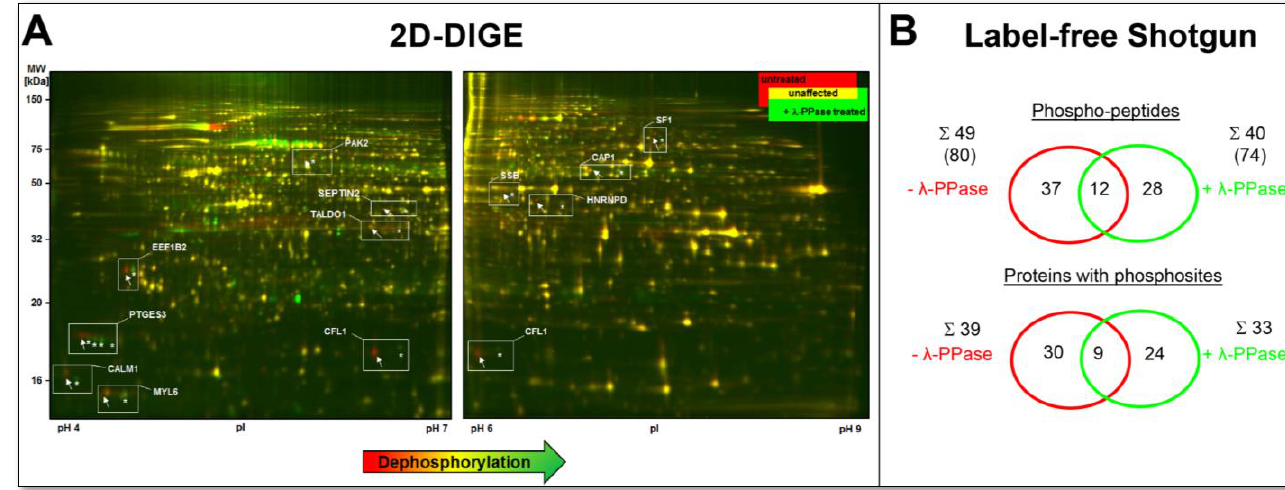
Figure 9. Characterization of phosphorylated proteoforms with 2D-DIGE and label-free shotgun. Supplementary Figure S4. Abbreviations: 2D-DIGE—two-dimensional difference gel electrophore-